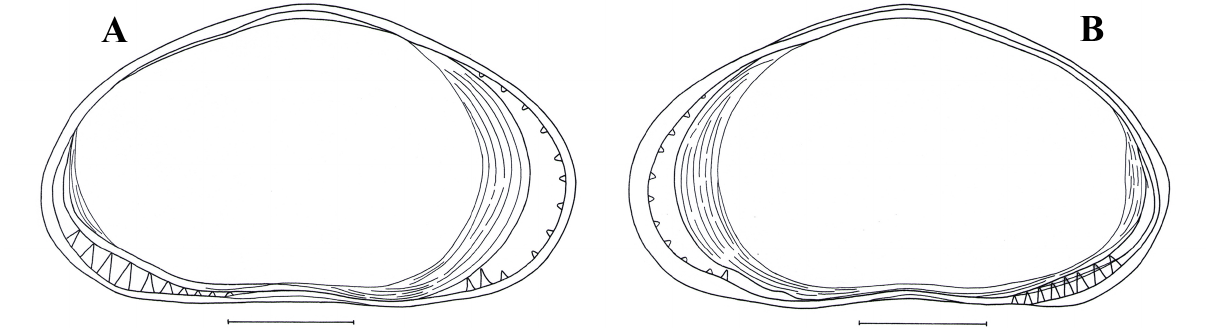
Fig. 2. Cyprettadopsis sutura gen. et sp. nov., ♀ (MSU-ZOC.268), drawn with transmitted light. A . LV, internal view. B . RV, internal view. Scale bars: